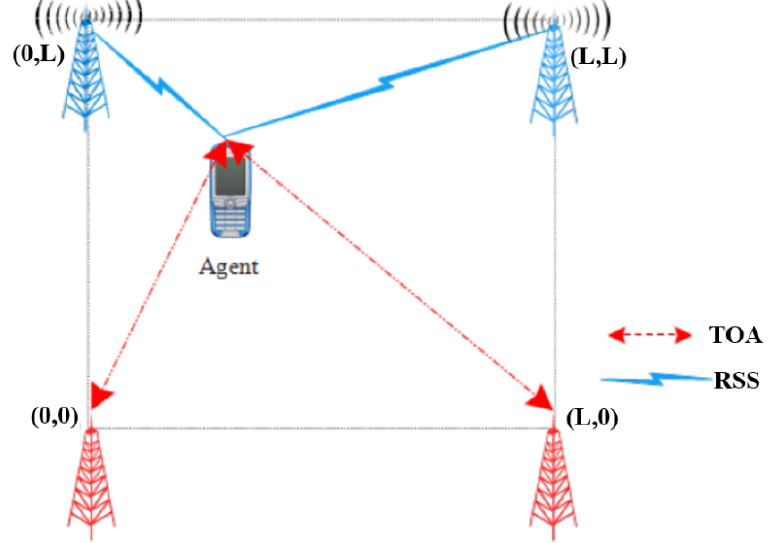
Figure 14. Distribution of the sensors and emitter for the proposed scenario